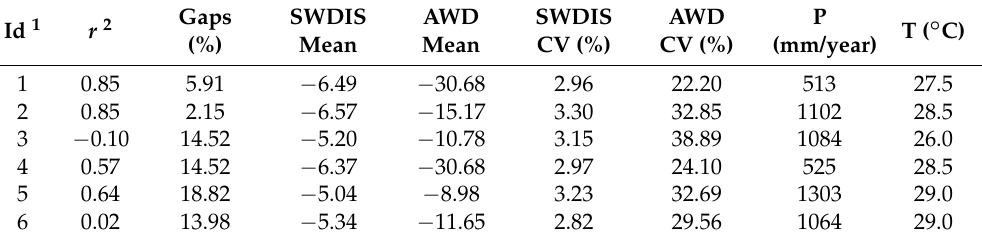
Figure 6. Comparison of the temporal evolution of the AWD and SWDIS for the same benchmark sites displayed in Figure 5 from June 2010 to December 2013. The black and red lines depict the weekly values of AWD and SWDIS, respectively. The dashed vertical lines in each panel depict the end of 2010, 2011, 2012, and 2013, respectively. Whited segments indicate gaps or omitted values. Table 2. Main statistical parameters for the SWDIS and AWD at benchmark